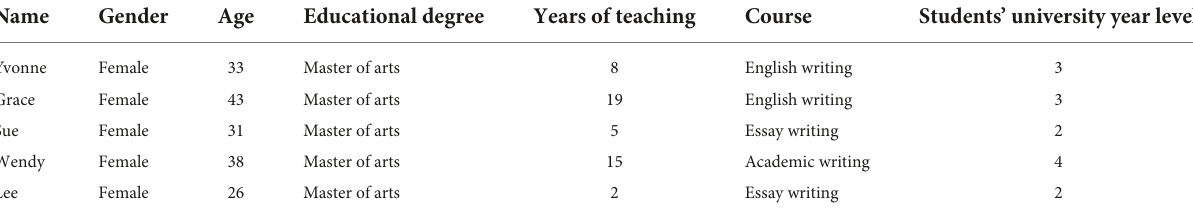
TABLE 1 Overview of participants’